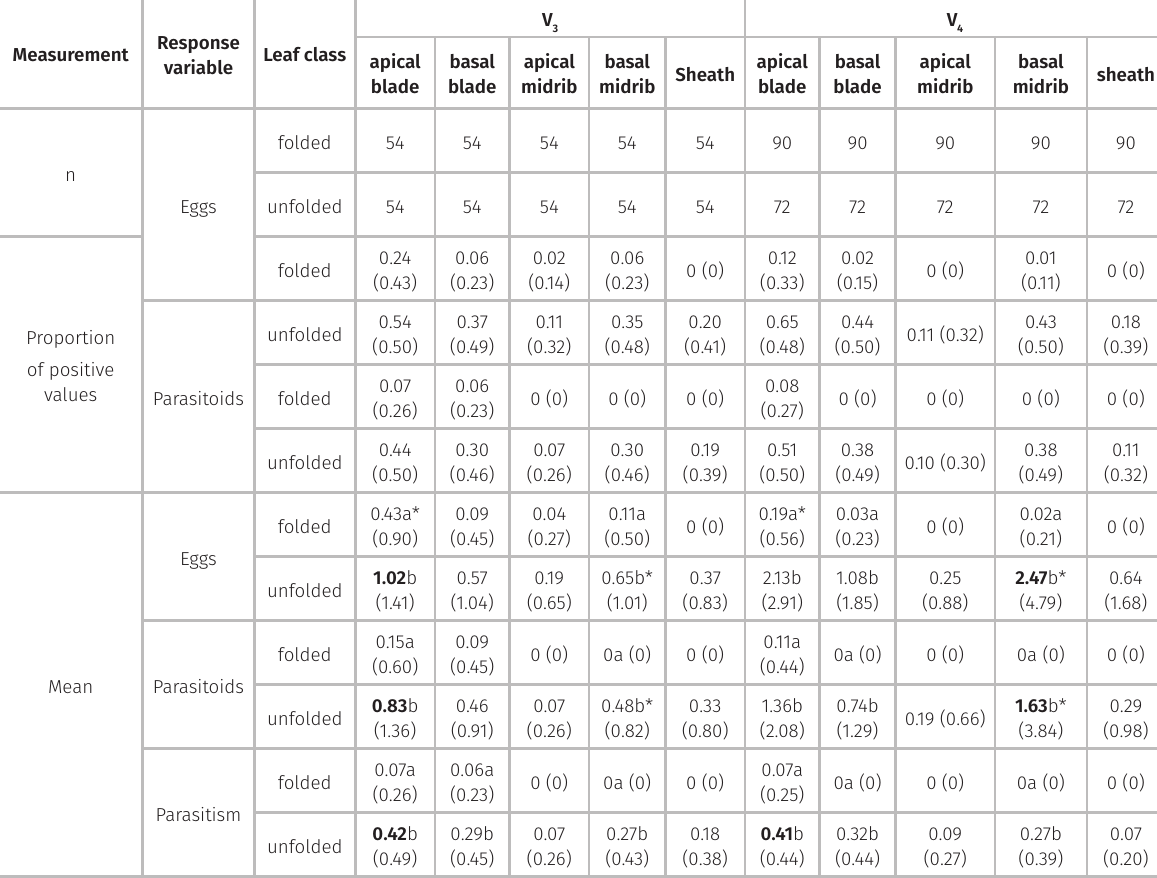
Table II. Descriptive statistics for the Dalbulus maidis dataset, according to the maize plant class, the leaf class and the position on the leaf. Data on “eggs” refer to the mean proportion of eggs/sector/plant; data on “parasitoids” refer to the proportion of emerged adult parasitoids; data on “parasitism” refer to the proportion of attacked eggs. Note: standard deviation is given within parentheses and the highest proportions are marked in bold. Significant mean differences between plant classes within each leaf class and sector location are indicated by an asterisk; significant differences between leaf class and sector location within each plant class are indicated by a different letter (Tukey HSD test; p <